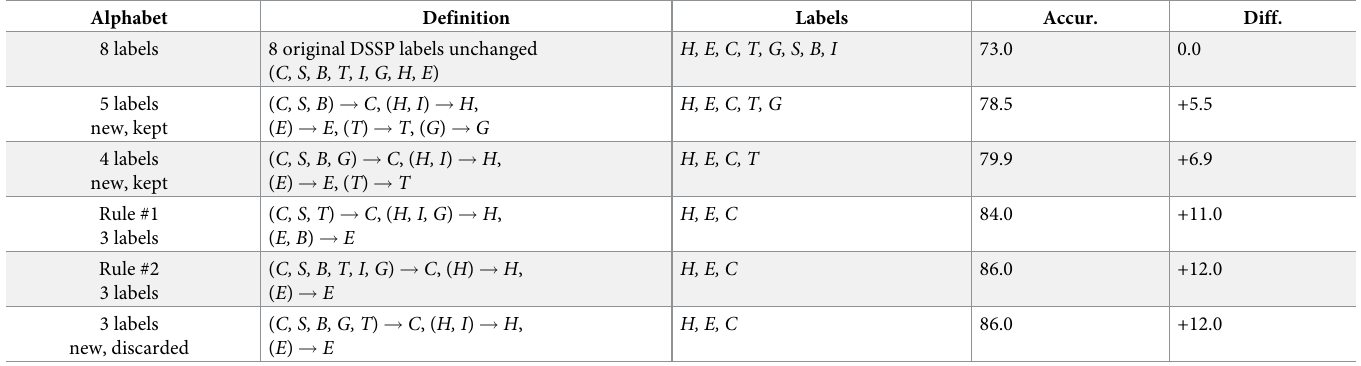
Table 13. Definitions of different label alphabets and associated SecNet accuracies on Test2018 test